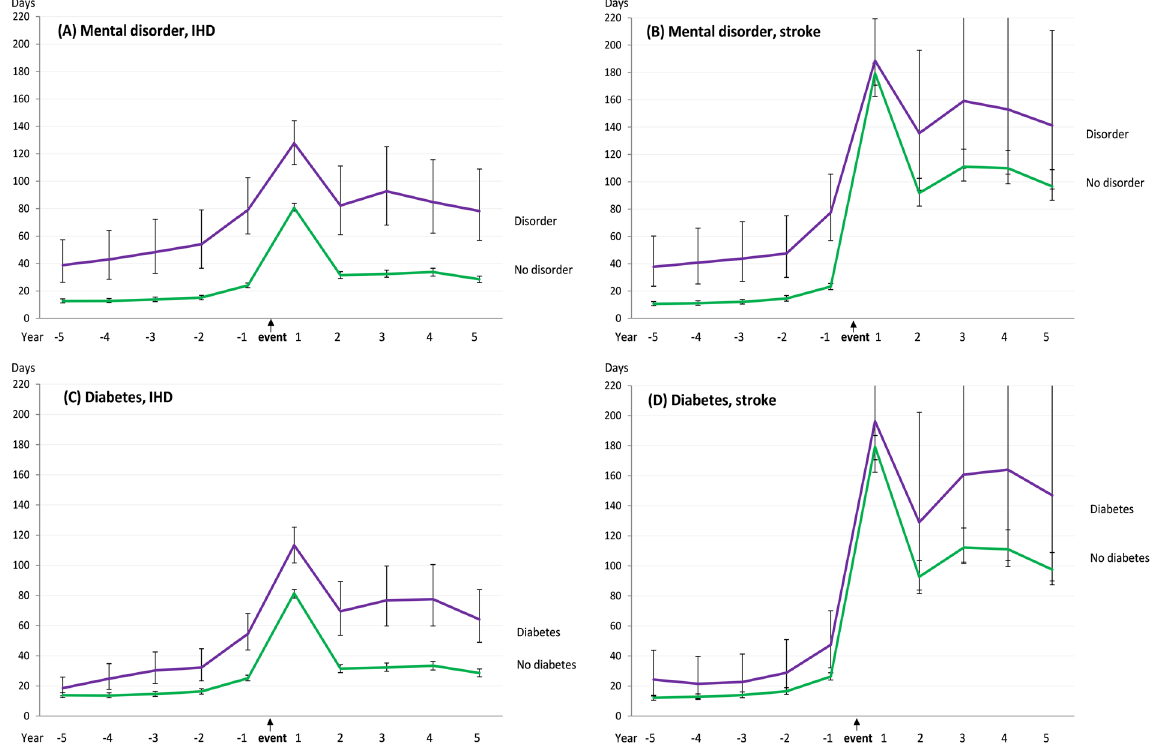
Figure 3. Mean days (95% confidence intervals) of work disability 5 years before and 5 years after newly diagnosed ischemic heart disease (IHD) or stroke event, by mental disorder and diabetes status (adjusted for age, sex, and